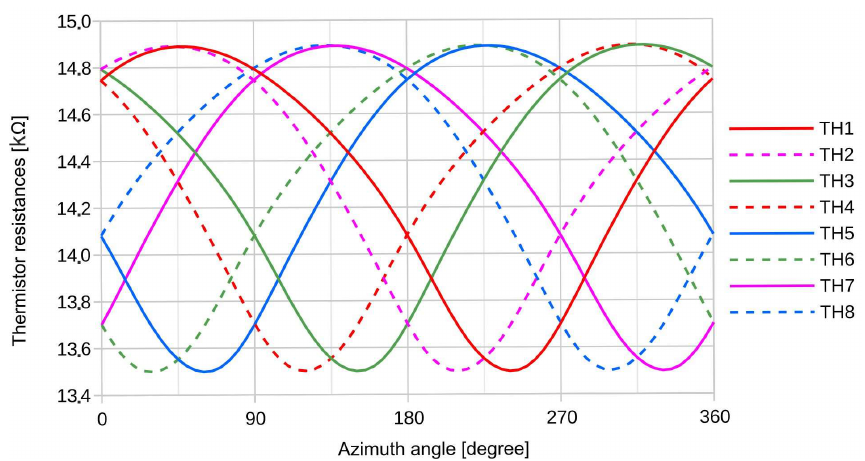
Figure 8. Simulated resistance variations with the direction of flow. The relative variation due to a 360 ◦ change of the flow direction of the thermistor resistances is of the order of 10% reflecting a temperature variation of ~5 K.